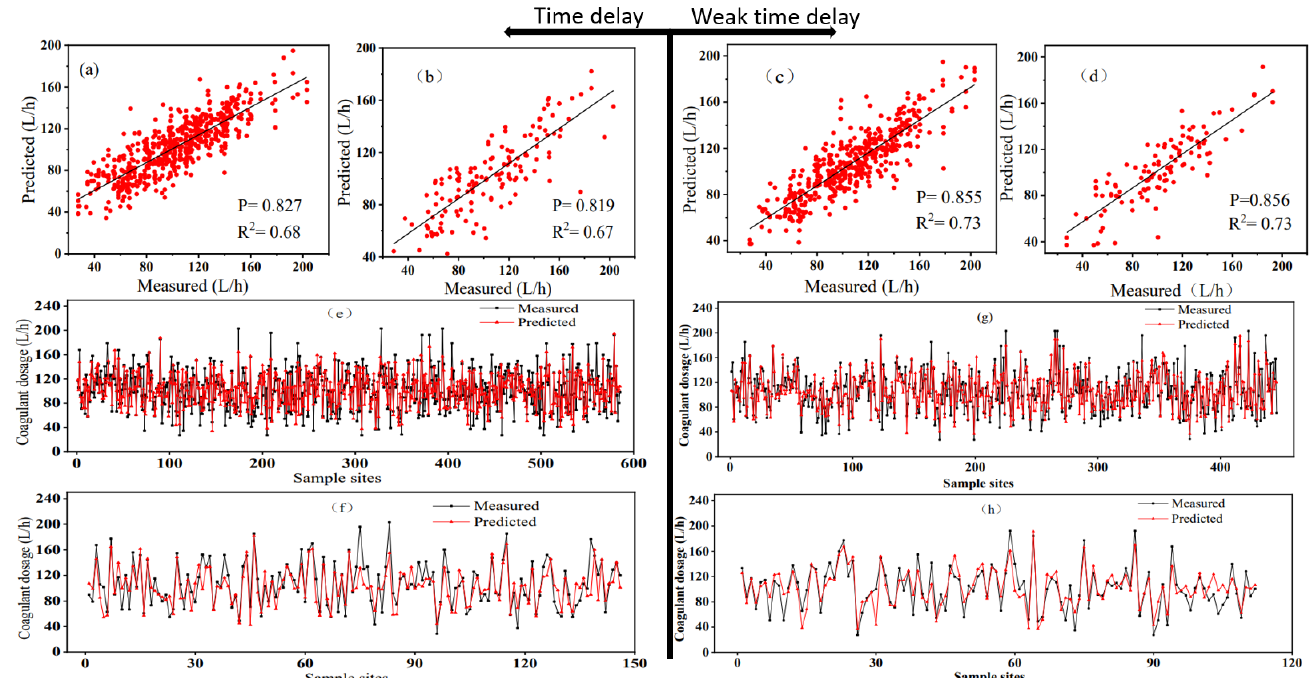
Figure 7. Correlation plots of simulated and measured values of ( a , b ) time-delay signal training and testing and ( c , d ) weak time-delay signal training and testing; distribution plots of simulated and measured values of ( e , f ) time-delay signal training and testing and ( g , h ) weak time-delay signal training and testing.